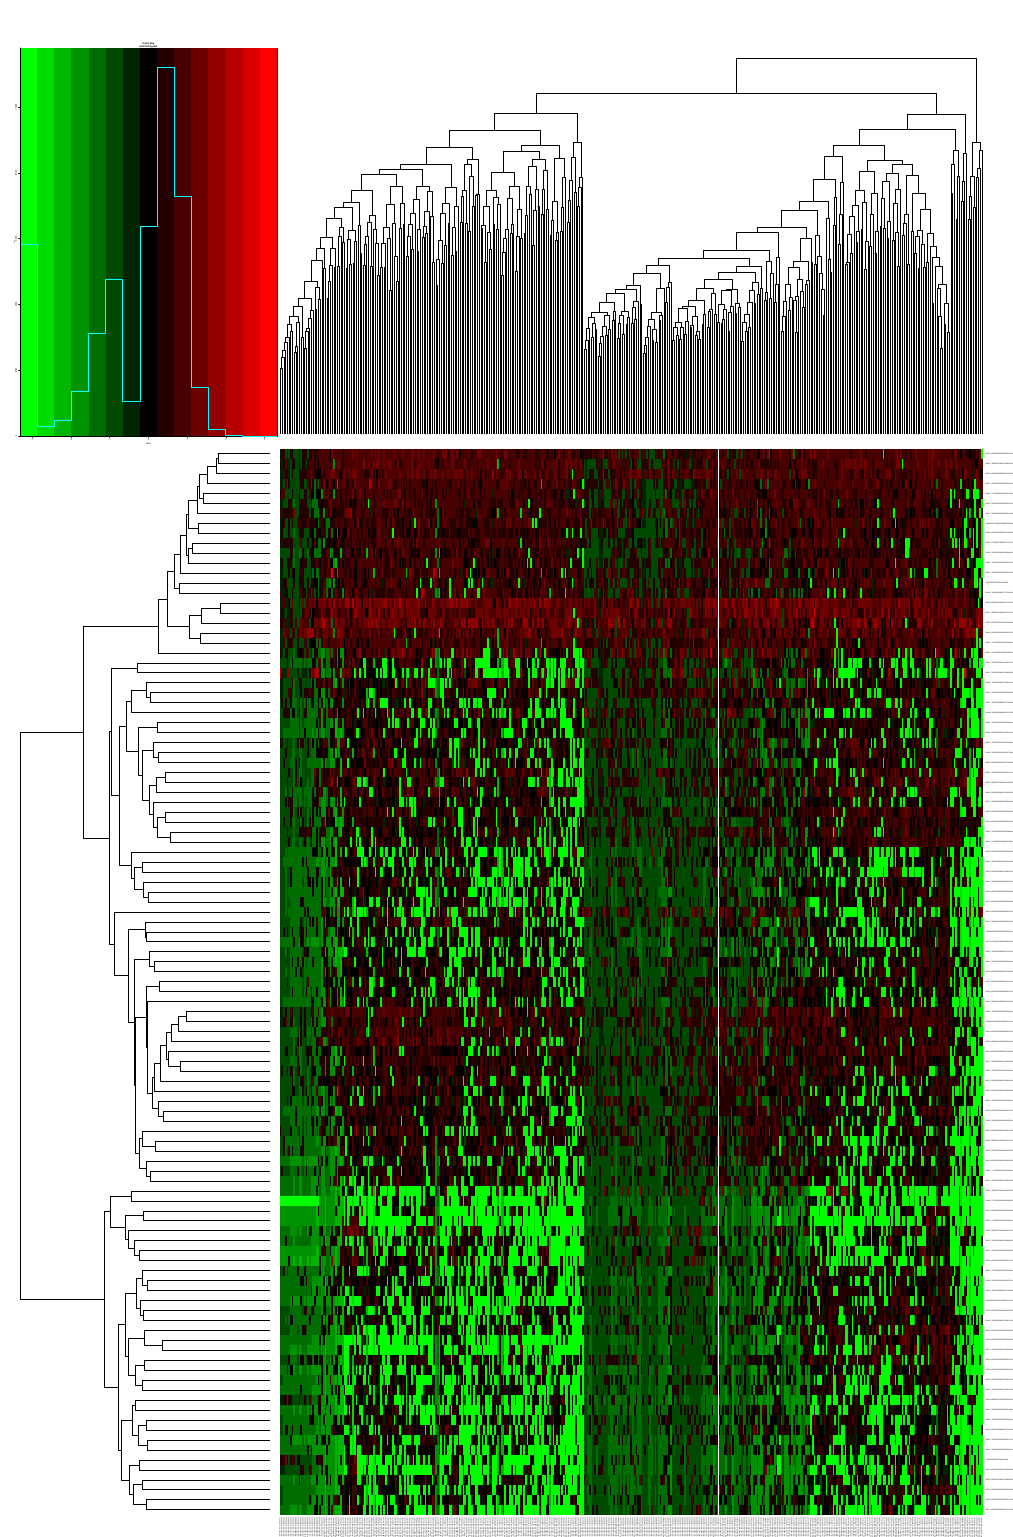
Figure S1: Heat map of di ff erentially expressed snRNAs between tumor and paracancer tissues of gastric